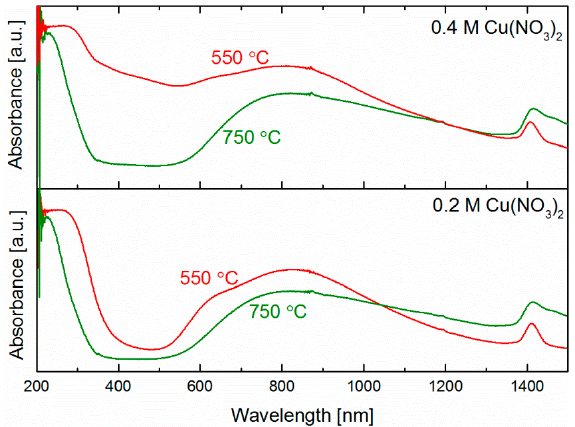
Figure 12. UV-vis spectra of Cu/SAPO-34 calcined at two different temperatures (550 and 750 °C). Top panel: 1.49 and 1.60 wt % Cu. Bottom panel: 1.27 and 1.20 wt % Cu.